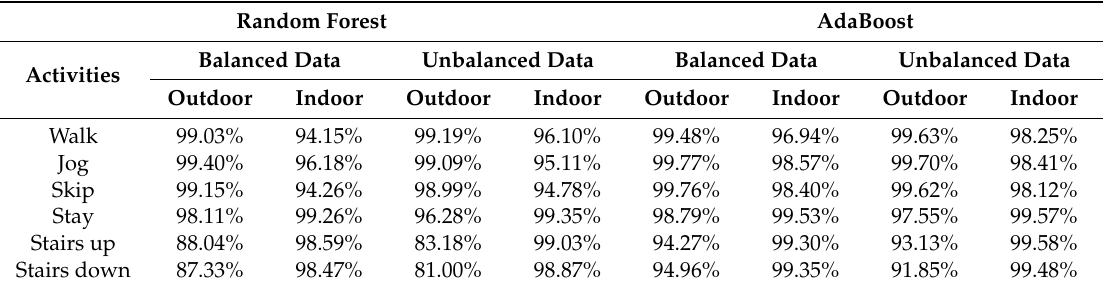
Figure 6. The impact of degree of unbalance on classification performance: ( a ) Random Forest classifier performance ( b ) AdaBoost classifier performance. performance ( b ) AdaBoost classifier performance. Table 7. The impact of the unbalanced dataset on the user IO status detection. Table 7. The impact of the unbalanced dataset on the user IO status detection.